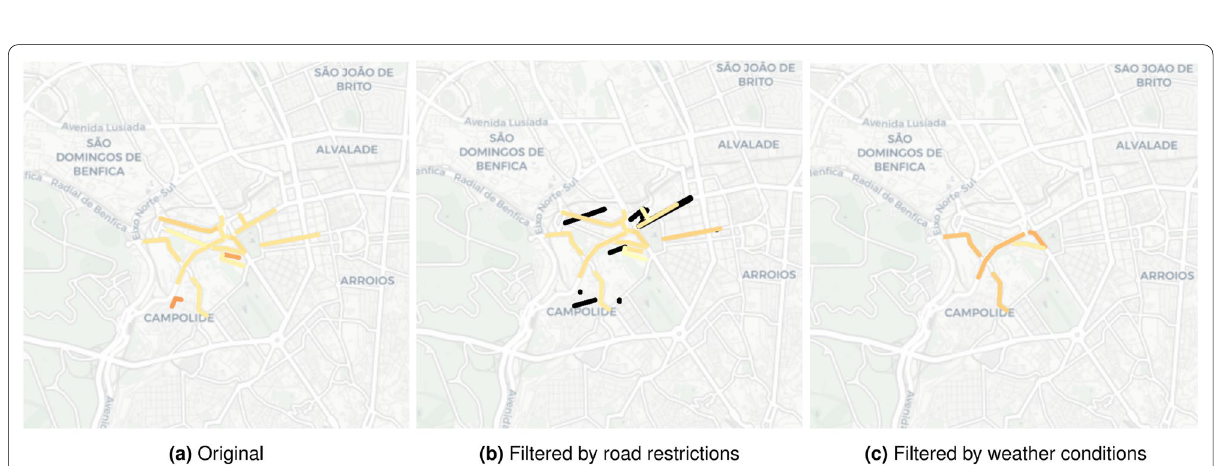
Fig. 10 Map visualization of geolocalized speed data: a without situational context; b filtered by road restrictions (visually depicted in black); and c filtered by air humidity superior to